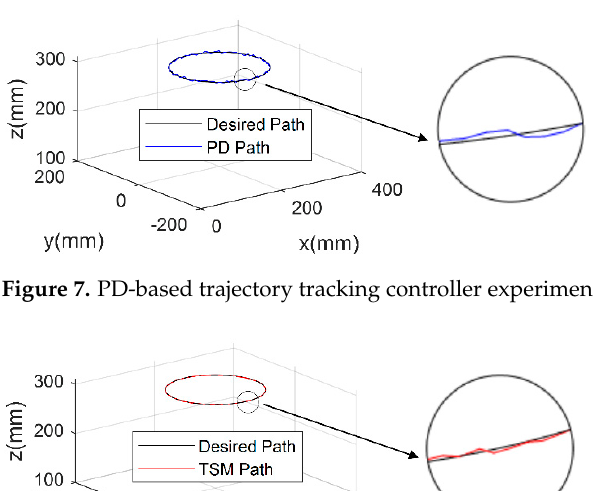
Figure 6. TSM-based controller experimental result. ( a ) TSM sinusoidal trajectory tracking experiment results. ( b ) TSM sinusoidal tracking experimental error value.